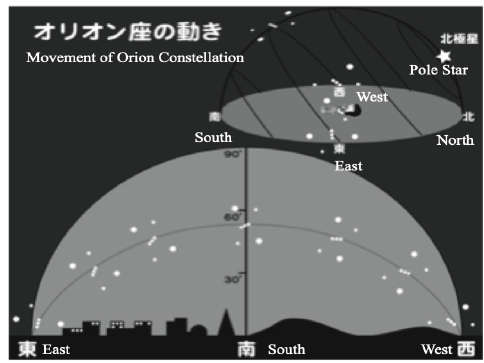
Figure 3. Planetarium content regarding the orbit of the Orion constellation over a